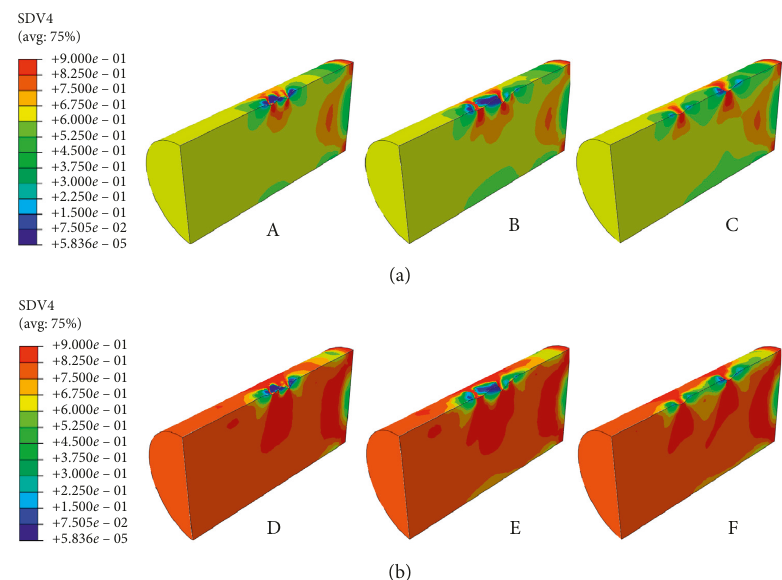
Figure 29: Damage nephogram of steel wires corresponding to the points in Figure 28: (a) step � 325; (b) step �